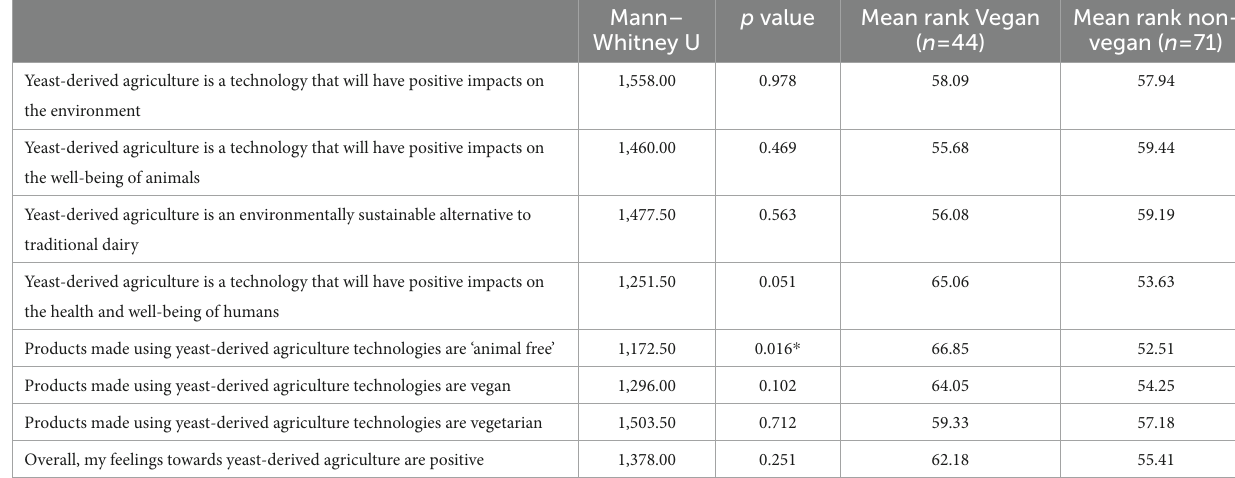
TABLE A2 Mann–Whitney tests for perceptions and attitudes toward yeast-derived